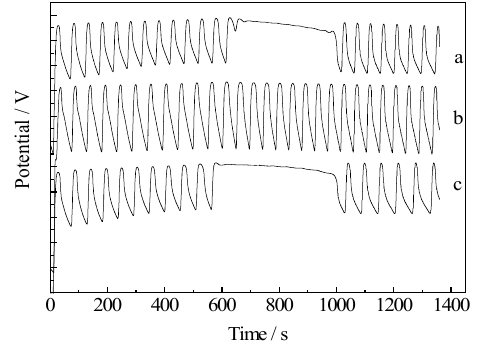
Figure 2. Potential-time profile of B-Z oscillating system at different experimental conditions.